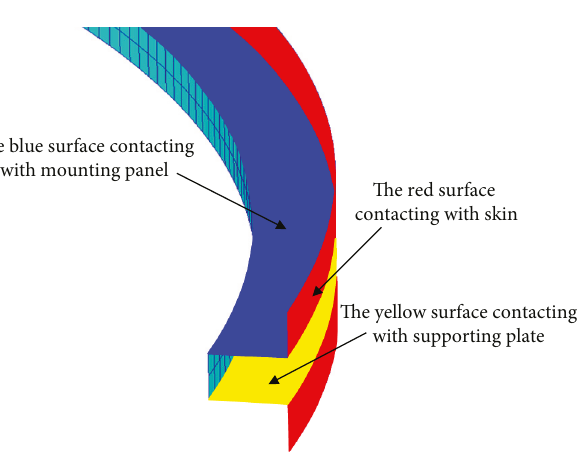
Figure 7: Finite element model of the circular